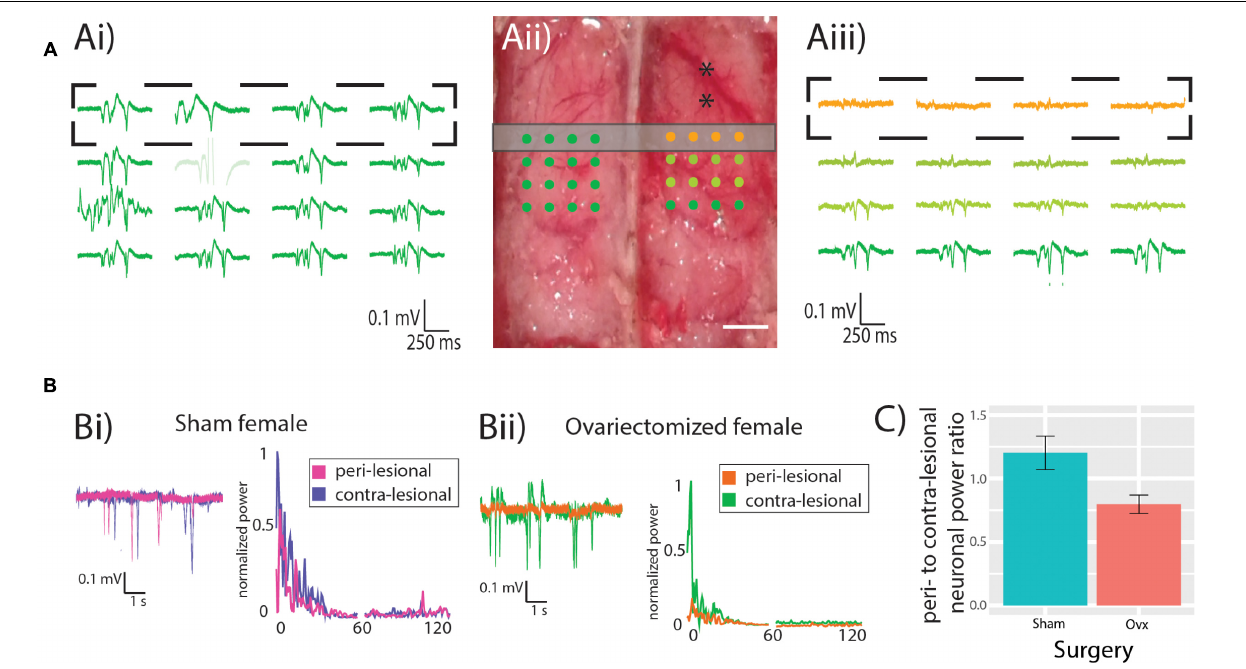
FIGURE 2 | Neuronal power. (A) Representative recording from contra- (Ai) and ipsi-lesional (Aiii) hemispheres, showing in orange the recordings from the peri-lesional tissue. Experimental design showing the MEA location (dots) in relation to the ET-1 injection sites (black asterisks) and the location of the CASL imaging slice (gray rectangle). Scale bar 0.5 mm. (B) representative recordings and power spectrum from the peri-lesional and contra-lesional hemisphere of Sham (Bi) and Ovx (Bii) animal. (C) Ovx animals (red bar) show a trend toward reduced neuronal power in the peri-lesional tissue when compared to that of Sham animals (green